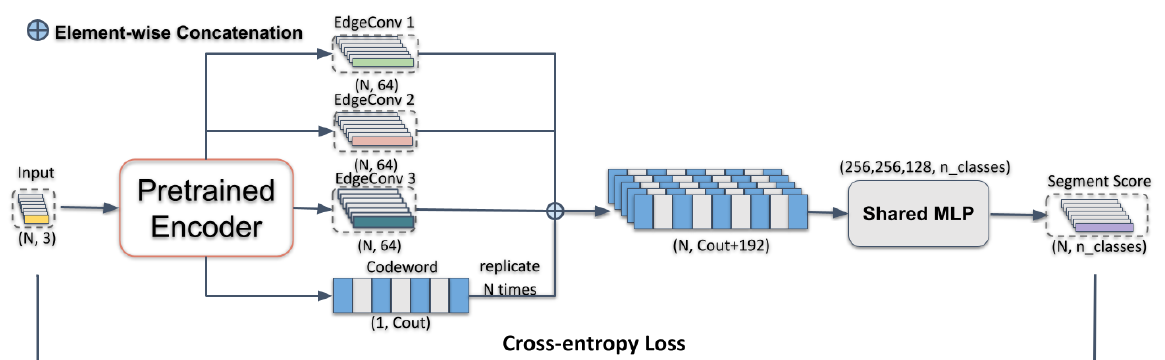
Figure 2 . The architecture of the semantic segmentation network. The network takes the outputs of pre-trained AE as input. It is trained to output pointwise segmentation scores of building point clouds by simply shared Multilayer Perceptron